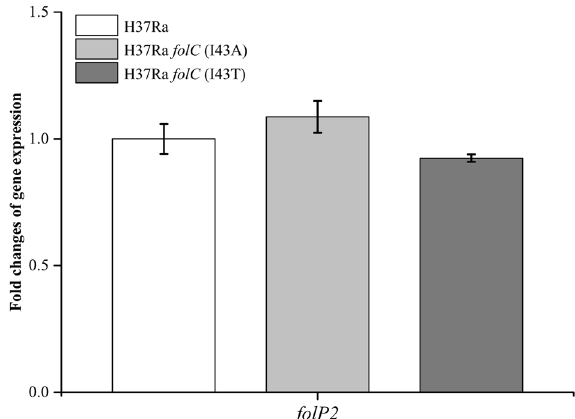
Figure 3. Comparison of the transcription levels of the gene folP2 during the exponential phase in wild-type H37Ra and H37Ra folC point mutant strains (I43A, I43T) by quantitative real-time PCR. mRNA expression levels were normalized against sigA as an endogenous control. Data are representative of three experiments. Standard deviations are indicated by error